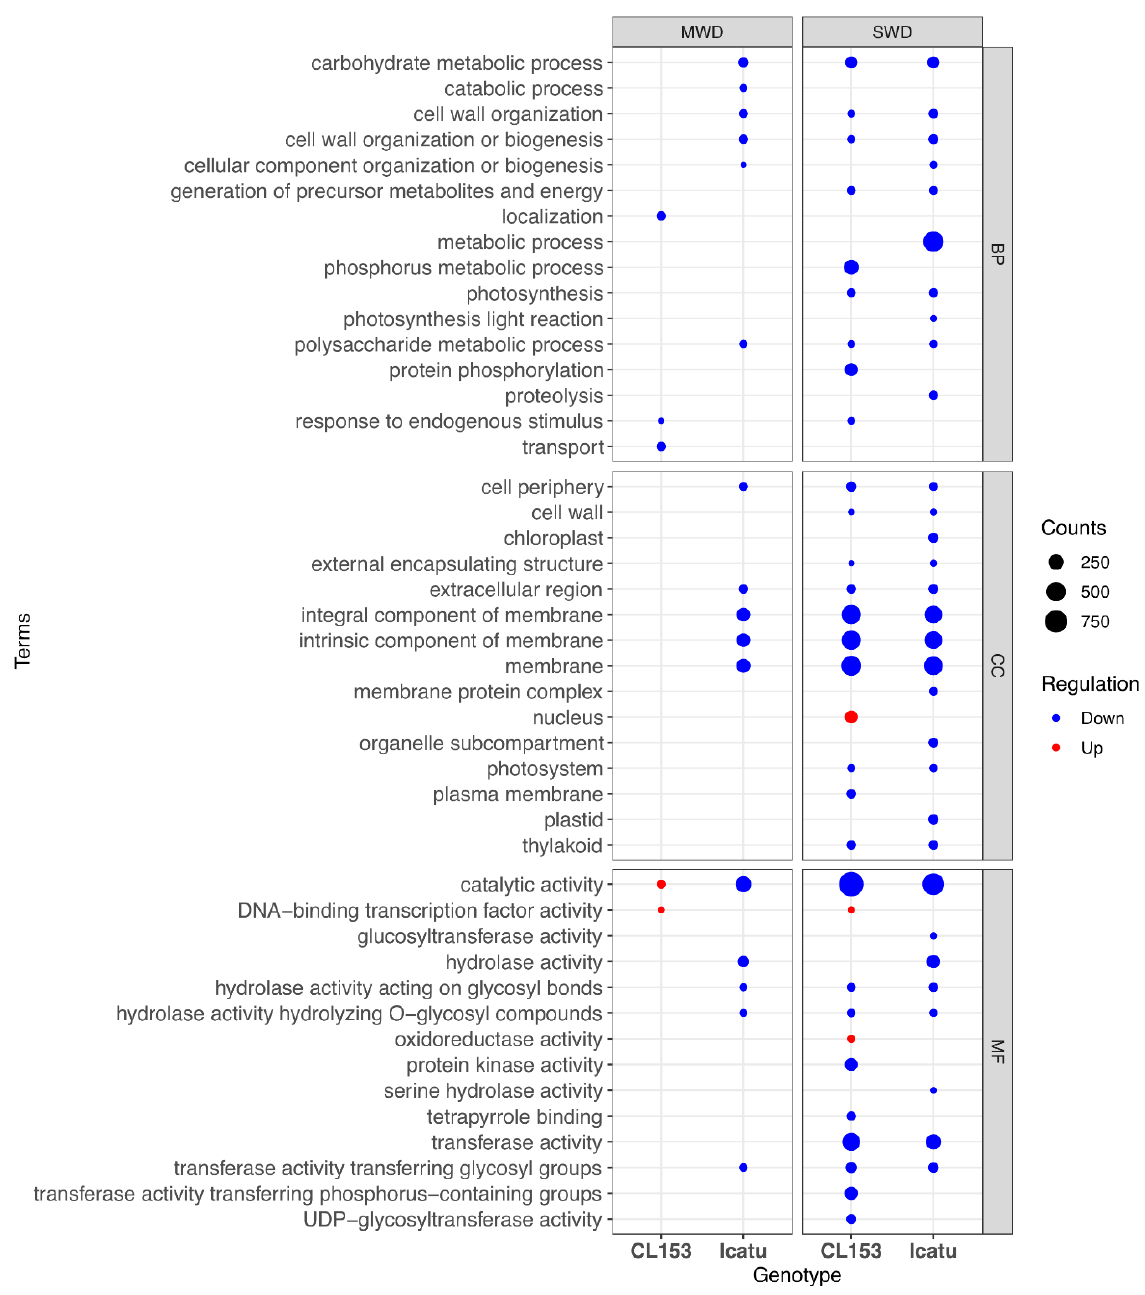
Figure 5. Over-representation analysis of Gene Ontology (GO) terms performed with gProfiler against the functional annotation of Coffea canephora genome. Top significantly enriched GO terms among up- and down-regulated differentially expressed genes (DEGs) were ranked by increasing log2 fold change (FC), considering the effect of moderate water deficit (MWD) and severe water deficit (SWD) conditions, compared to well-watered plants (WW) condition in Coffea arabica cv. Icatu (Icatu) and C. canephora cv. Conilon Clone CL153 (CL153) plants. Terms were filtered by REVIGO with similarity = 0.5, FDR < 0.01 and Counts > 20. GO terms are grouped by the main categories: Biological Process (BP), Molecular Function (MF), and Cellular Component (CC). Counts (size) indicate the number of DEGs annotated with each GO term, and dots are colored by type of regulation (red: up-DEGs; blue: down-DEGs).